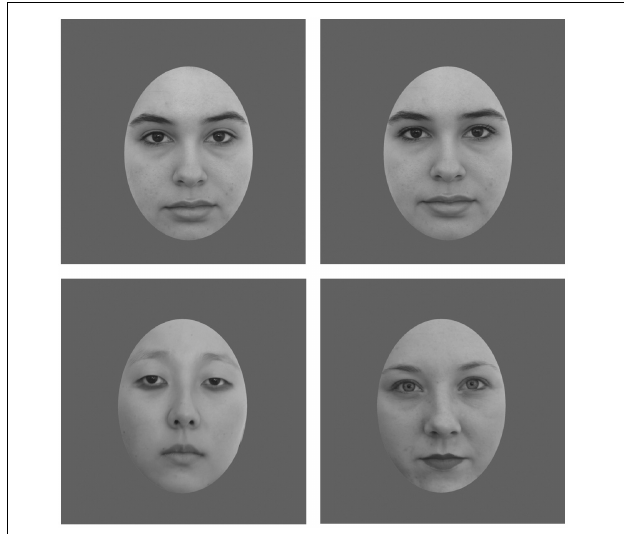
FIGURE 2 | Top Left : example of original face with no-makeup. Top Right : example of face with upper eye makeup. Bottom Left : Example of face with under eye makeup. Bottom Right : Example of face with lip